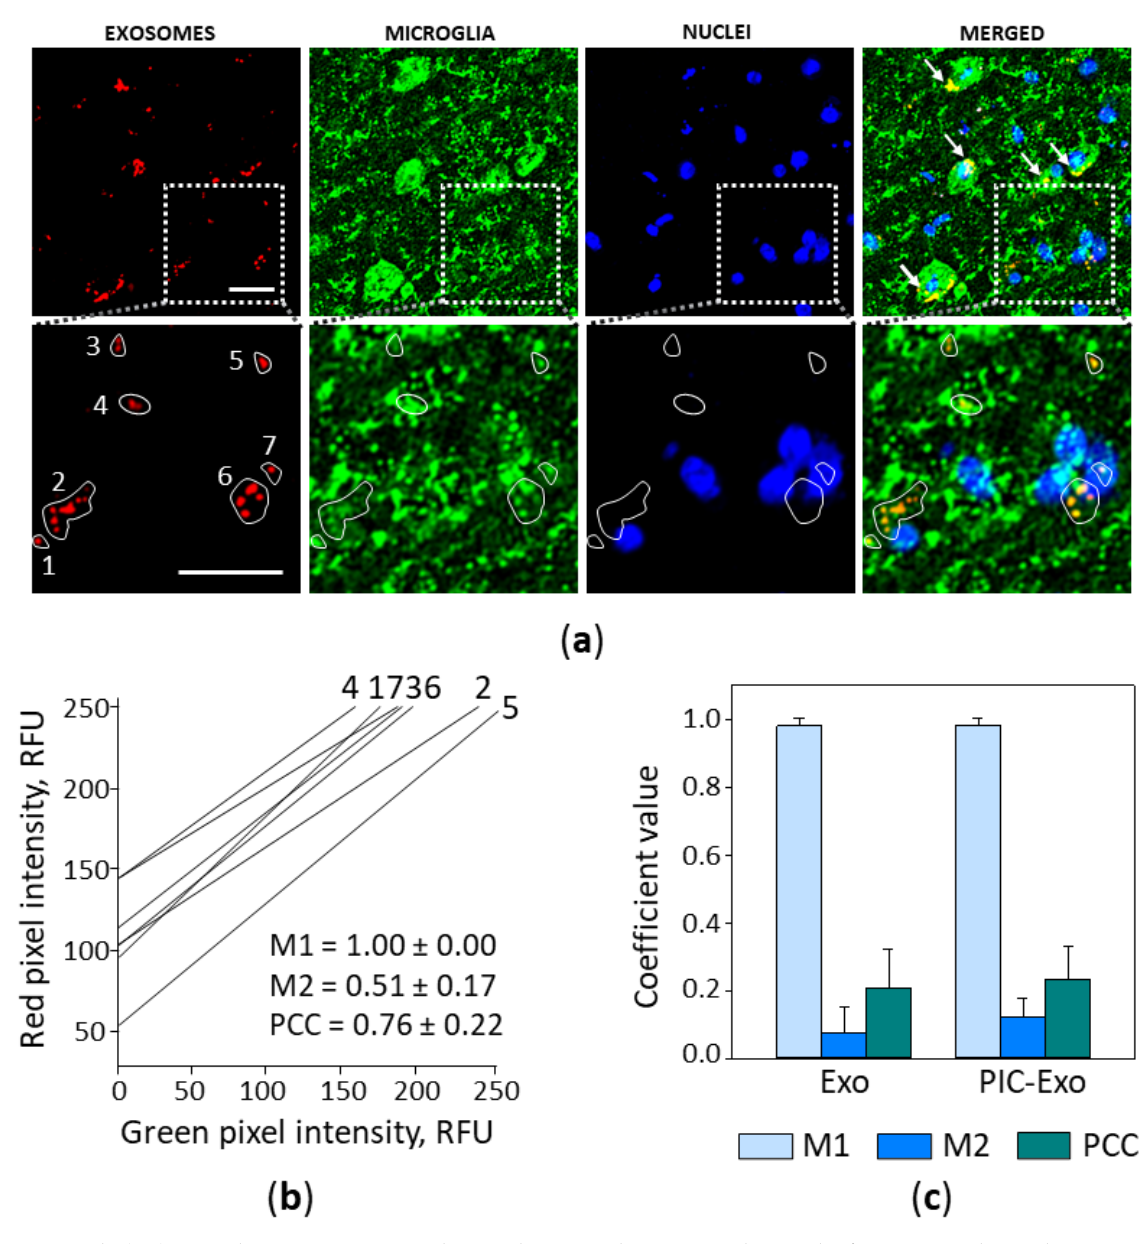
Figure 4. Poly (I:C)-treated airway ELV internalisation by microglia in mouse brain 2 h after intranasal introduction. In ( a ), a representative brain slice image, where particles loaded with RNR-conjugated AF555 are red, nuclei are stained blue with DAPI, and microglial cells are green, visualised by immunostaining against TMEM119. White arrows indicate microglial cell bodies with colocalised ELVs (upper image row, MERGED), and particles colocalising with microglial processes is visible in the zoomed ROI image (lower image row). The scale bar is 20 µ m. Colocalisation analysis in seven small ROIs indicated by the white lines was performed by ImageJ plugin JACoP; cytofluorograms, Mander’s and Pearson’s coefficient values are presented in ( b ). Results of colocalisation analysis in full-size images are shown in ( c ), n = 15. M1—Mander’s overlapping coefficient showing the red fluorescence fraction overlapping the green, M1—the green fraction overlapping the red; PCC—Pearson’s correlation coefficient. Exo—images of the slices from brains treated with ELVs from control airway cells; PIC-Exo—from poly (I:C)-treated airway cells. The colocalisation analysis of the ROI marked by the white line in the zoomed (lower) image row revealed a strong correlation between ELV and microglial staining (Figure 4b). The diagonal positioning of cytofluorograms and close to 1 Pearson’s correla- tion coefficient (PCC) indicates a similar distribution of red (ELVs) and green (microglia) pixel intensity. Mander’s 1 coefficient (M1) value is 1.00, and this means that all the